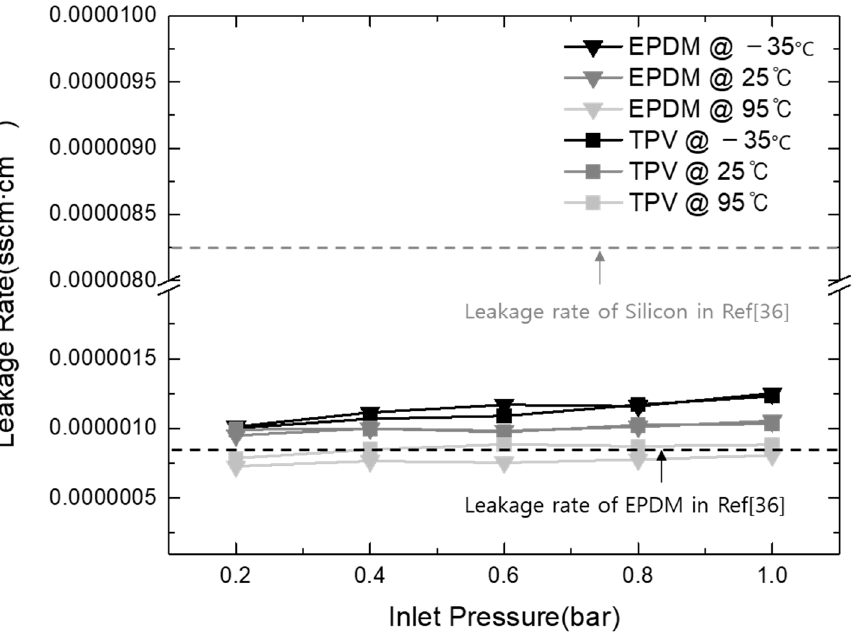
Figure 8. Comparison of leakage rates of gasket materials prepared in this study with results from the literature.